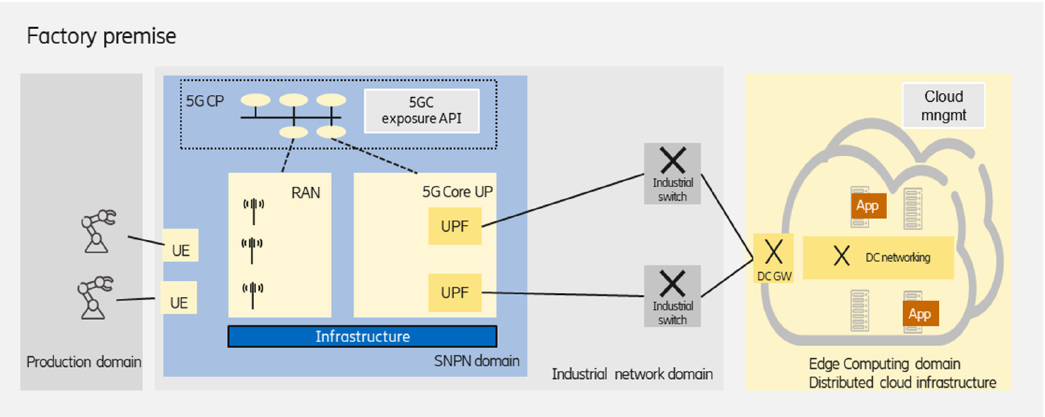
Figure 2. Standalone NPN with factory premises edge.